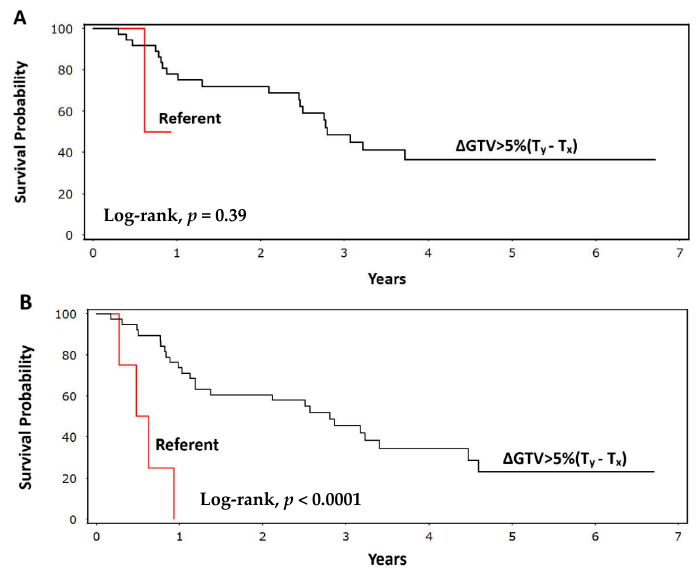
Figure 2. Kaplan–Meier plots showing ( A ) recurrence ‐ free survival ( p = 0.39) and ( B ) overall survival ( p < 0.0001) for patients with a change in gross tumor volume (GTV) greater than 5% during at least one week of chemoradiation ( Δ GTV > 5% (T y – T x )) compared with patients having a change in GTV of less than 5% (referent) during at least one week of treatment.